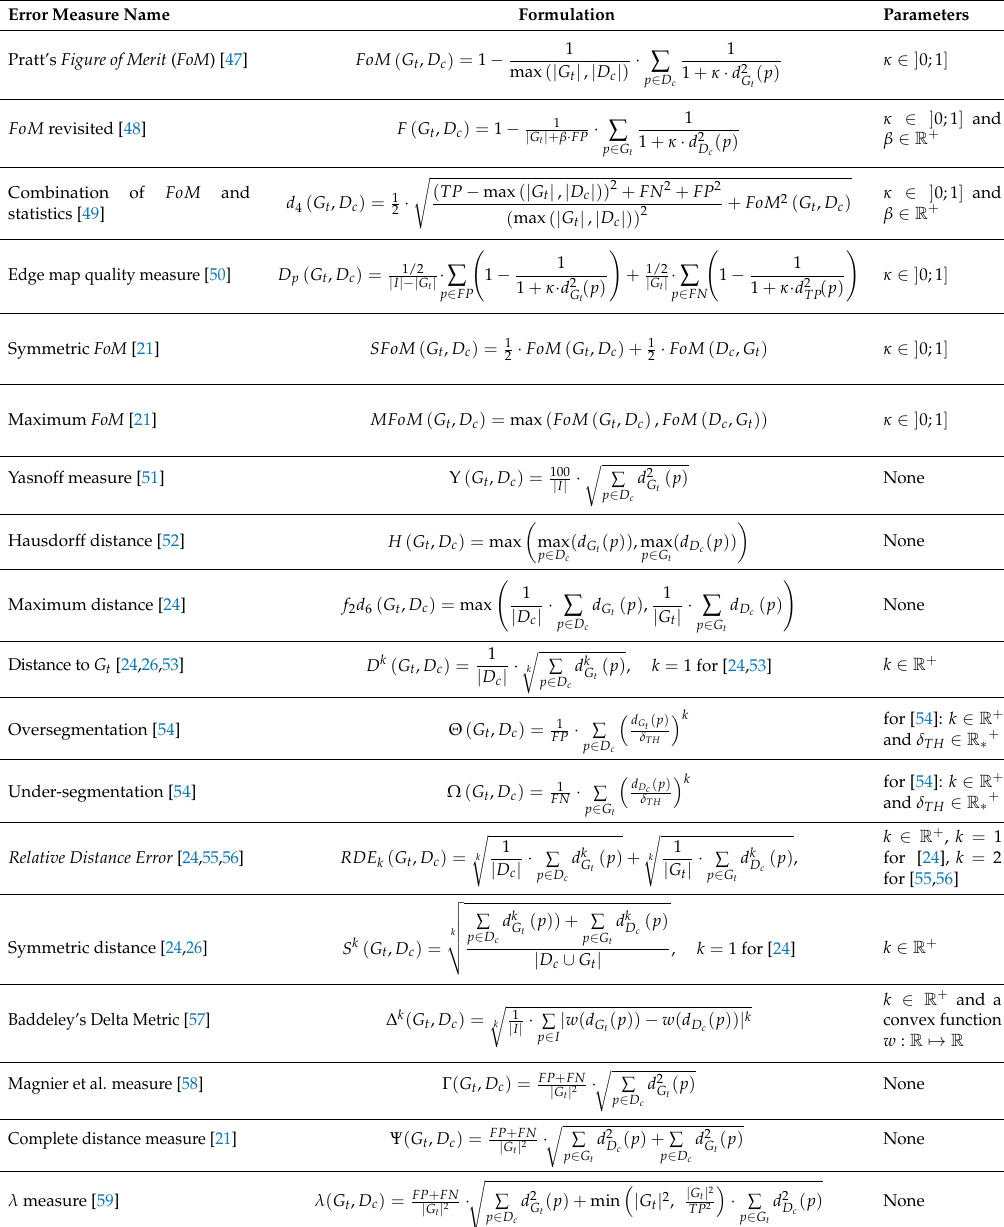
Table 4. List of error measures involving distances, generally: k = 1 or k = 2 , and, κ = 0.1 or κ = 1/9